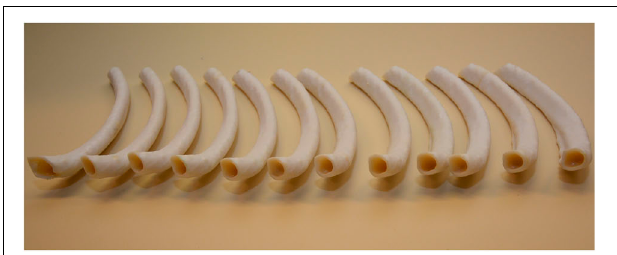
FIGURE 4 | Twelve 3D Printed rib specimens. Twelve 3D Printed replicates of the dorsal segment from the body of rib 7.